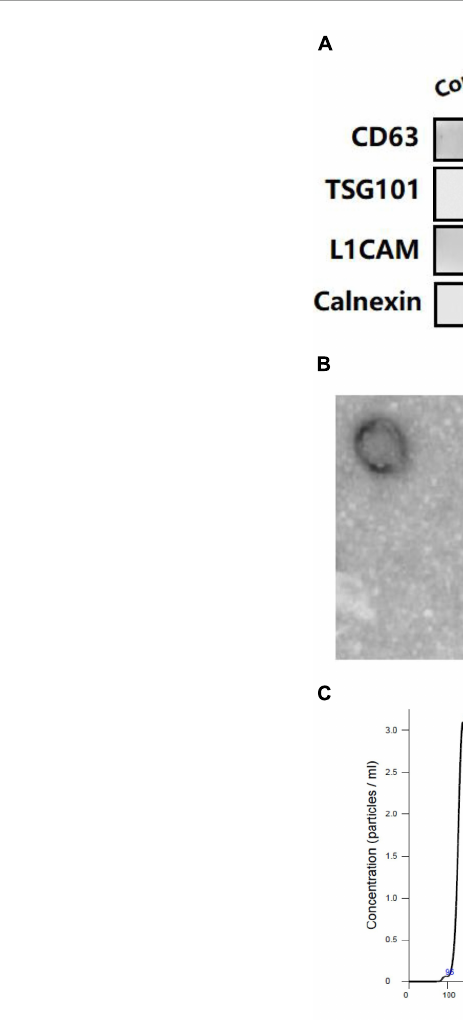
FIGURE2 Western blotting (WB) (A) , transmission electron microscopy (TEM) (B) and nanoparticle tracking analysis (NTA) (C) of plasma neuron derived exosomes. (A) : Control: negative control for the immunoprecipitation using Streptavidin-Plus UltraLink resin alone without mouse anti-human CD171 biotinylated antibody. EXO: neuron-derived exosomes. Supernatant 1: Supernatant after immunoprecipitation. Supernatant 2: Supernatant after ExoQuick exosome